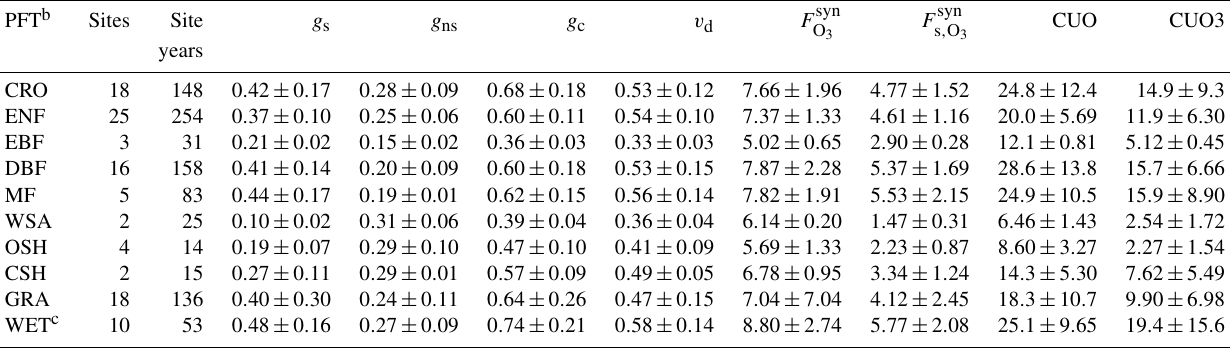
Table 2. Mean O 3 SynFlux, deposition velocity, and its conductance components during daytime in the growing season, grouped by plant functional type (PFT) a